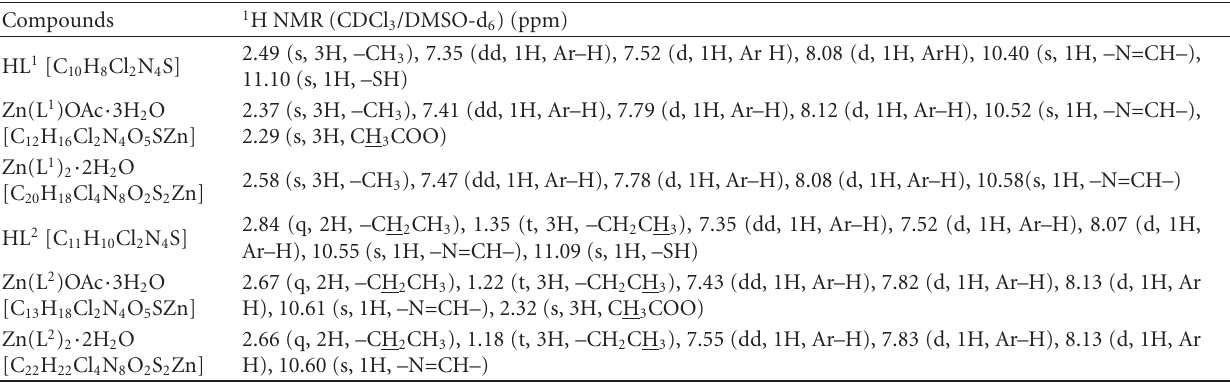
Table 2: 1 H NMR spectral data of Schi ff bases and their metal complexes.